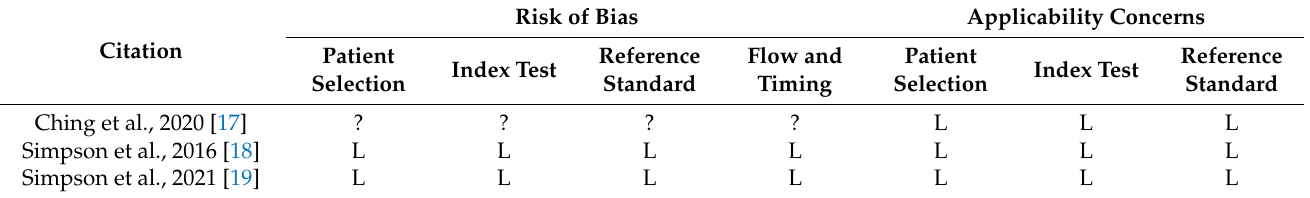
Table 1. Quality assessment using QUADAS-2.